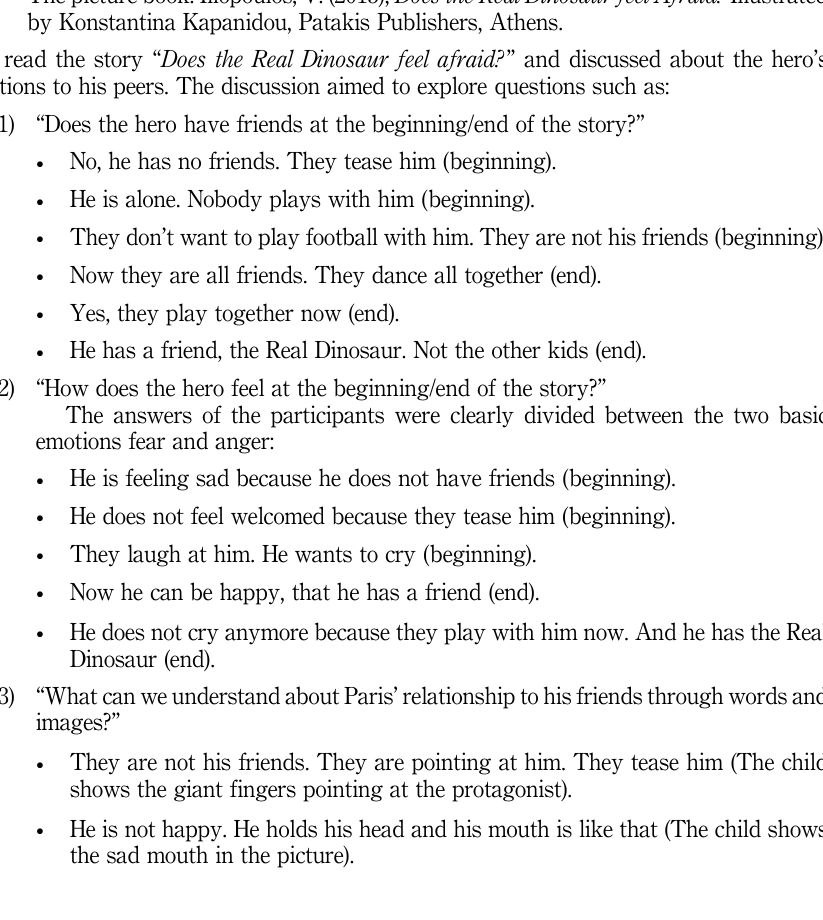
The picture book: Iliopoulos, V. (2015), Does the Real Dinosaur feel Afraid? Illustrated by Konstantina Kapanidou, Patakis Publishers,